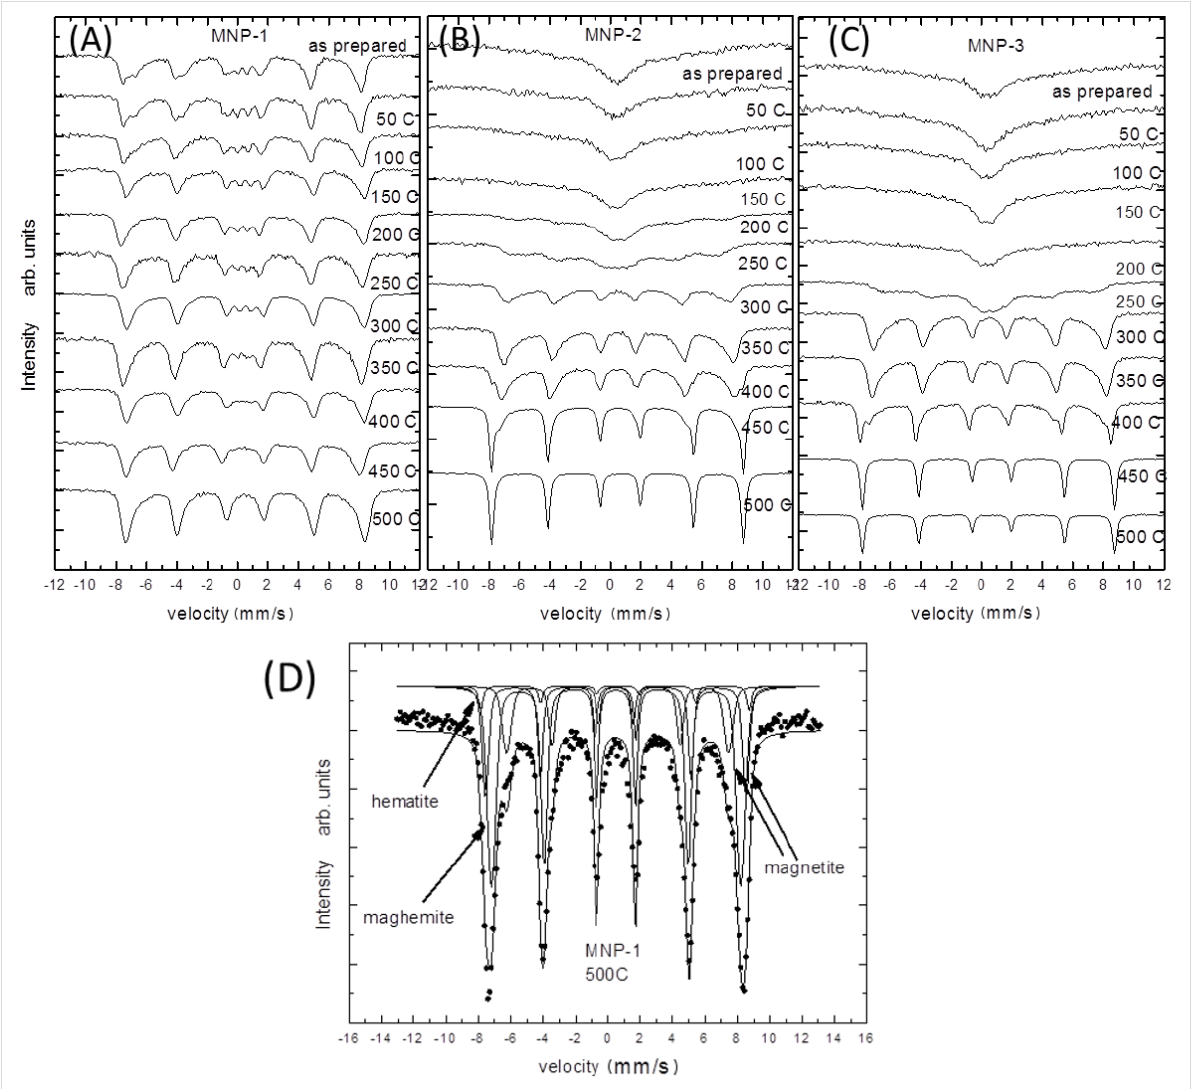
Figure 9: Mössbauer spectra of nanoparticles tested under different temperatures: (A) MNP-1, (B) MNP-2, (C) MNP-3 along with (D) examples of respective fits.